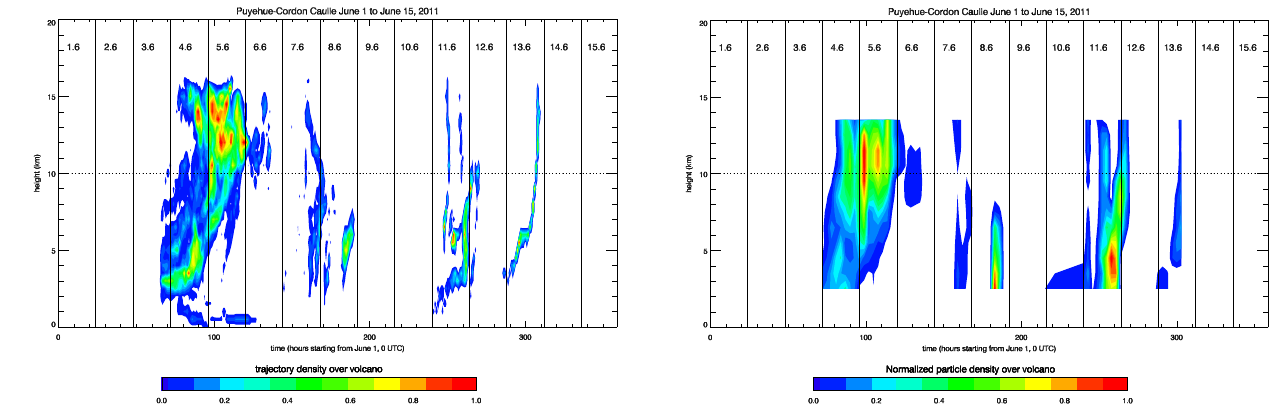
Fig. 8. Normalized particle density above PCC from 1 June to 15 June as indicator for the effective emission height of the volcanic ash derived by matching emitted particles with IASI